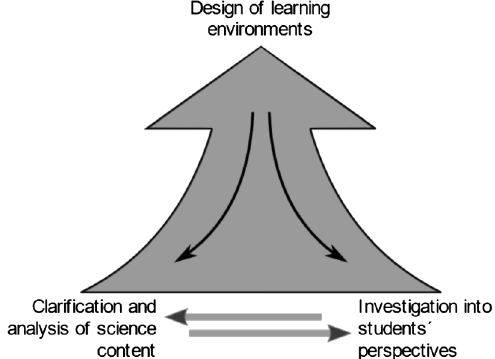
FIG. 2. The model of educational reconstruction adapted from Kattmann and Duit